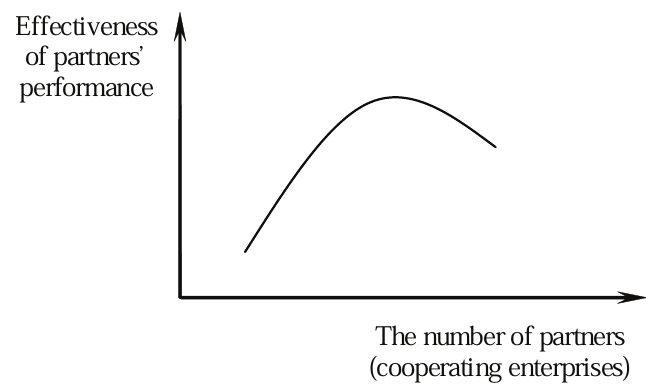
The number of partners (cooperating